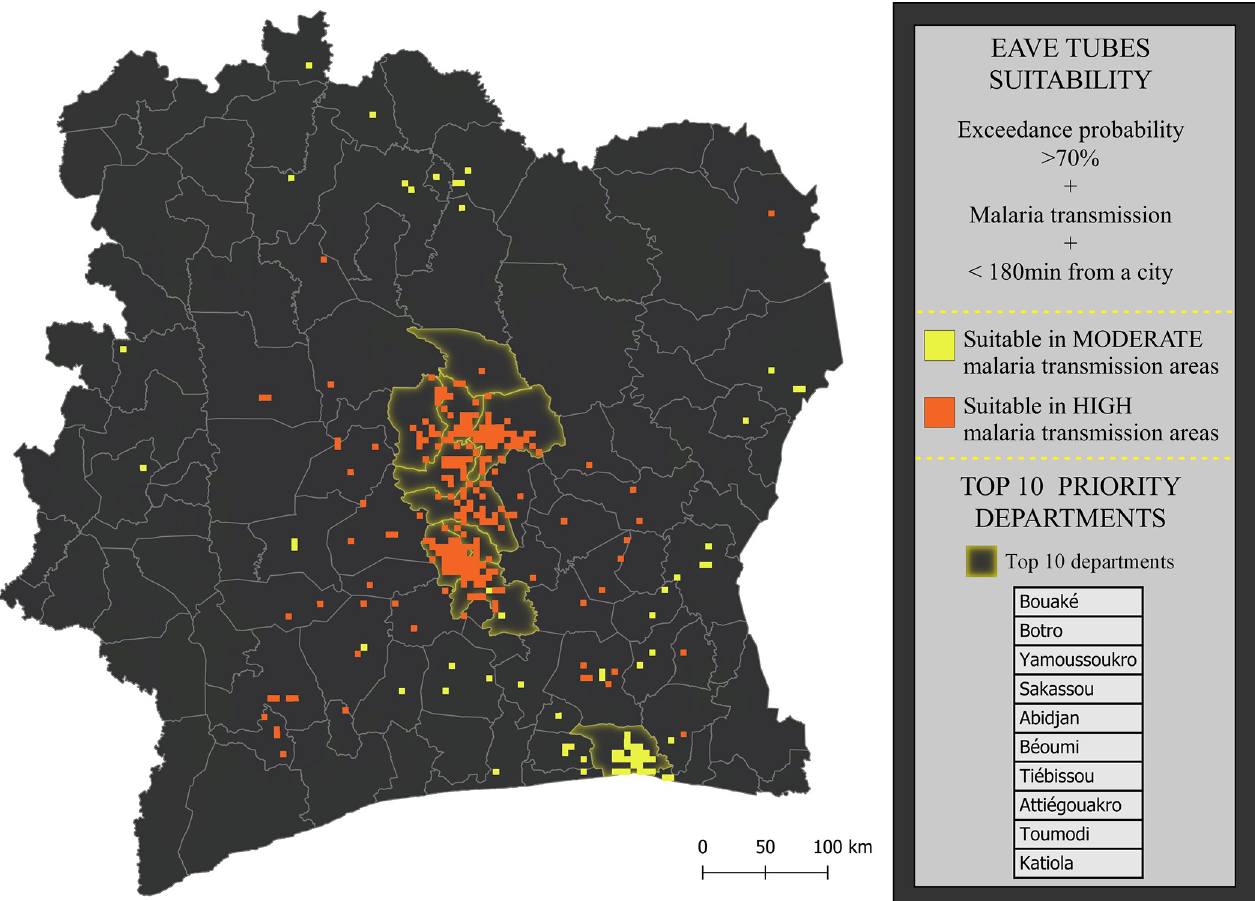
Fig 5. Priority areas for further ground-truthing in preparation for SET implementation prioritization and planning. Suitable areas (orange and yellow 5 km 2 squares) were identified by excluding areas with low malaria transmission ( < 10% parasite rate), low accessibility ( > 180 min from nearest city) or poor household suitability for SET (exceedance probability of > 70% from model output). Departments highlighted in yellow are the top ten priority departments after ranking them according to the exceedance probability, malaria transmission, and accessibility of grid squares within their borders. Basemap: https://data.